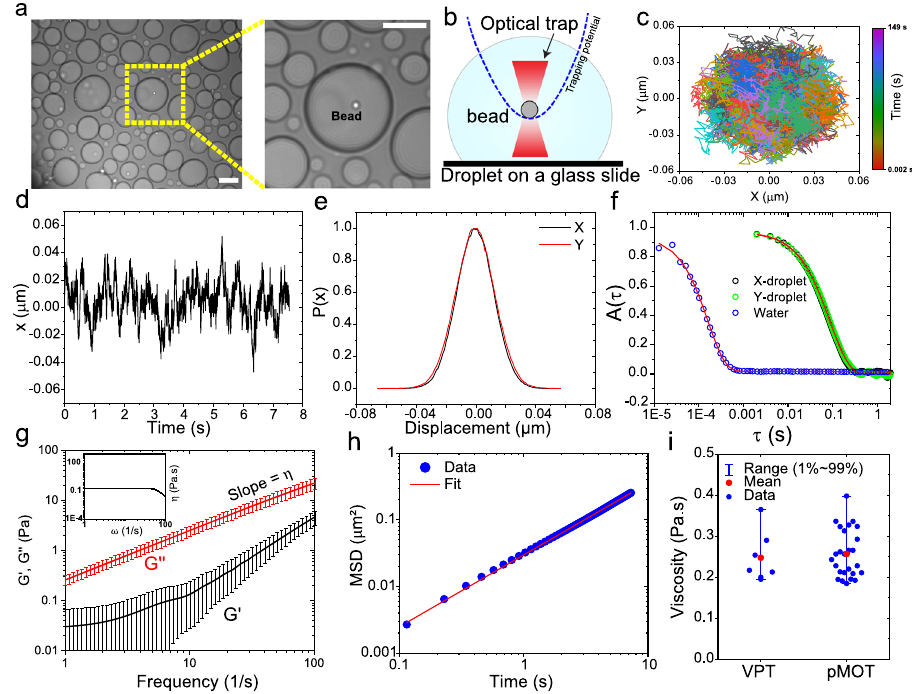
Fig. 1 Determination of frequency-dependent viscoelastic moduli of peptide-RNA condensates using passive microrheology with optical tweezers (pMOT). a A bright- fi eld image showing a polystyrene bead (1 µ m) trapped within a [KGKGG] 5 -rU40 condensate using an optical trap. Scale bar = 10 µ m. b A conceptual scheme of the pMOT experiment. The bead is optically trapped within a biomolecular condensate sitting on a microscope glass surface. c A representative 2D trajectory of the bead shown in (a) within the optical trap inside a [KGKGG] 5 -rU40 condensate. d The trajectory of the trapped bead in the X-direction. e Normalized distribution of displacements along the X- and Y-directions for the trajectory in c and d. f The normalized position autocorrelation function [NPAF, A(t)] as calculated from the trajectory in c for a bead that is optically trapped inside [KGKGG] 5 -rU40 condensate (green and black) and inside water (blue) as a reference. Solid lines are multi-exponential fi ts (see Supplementary Note 1). g The average viscoelastic moduli as obtained from normalized position autocorrelation function using equation-1 for [KGKGG] 5 -rU40 condensates. G ’ and G ” represent the elastic and viscous modulus, respectively. Solid lines are averages of the moduli of 10-20 condensates. Error bars represent the standard deviation as calculated from the moduli of 10-20 condensates. Inset : frequency-dependent condensate viscosity as determined from the viscous modulus using the relation η ð ω Þ ¼ G 00 ð ω Þ = ω . h The ensemble-averaged mean square displacement (MSD) of 200 nm polystyrene beads within [KGKGG] 5 -rU40 condensates using video particle tracking (VPT) microrheology in absence of optical traps (see Methods section for further details). i Comparison between the zero-shear viscosity as determined by pMOT ( n = 26 measurements over 3 independent samples) and VPT-derived ( n = 7 measurements over 3 independent samples) viscosity. Error bars represent the range of the